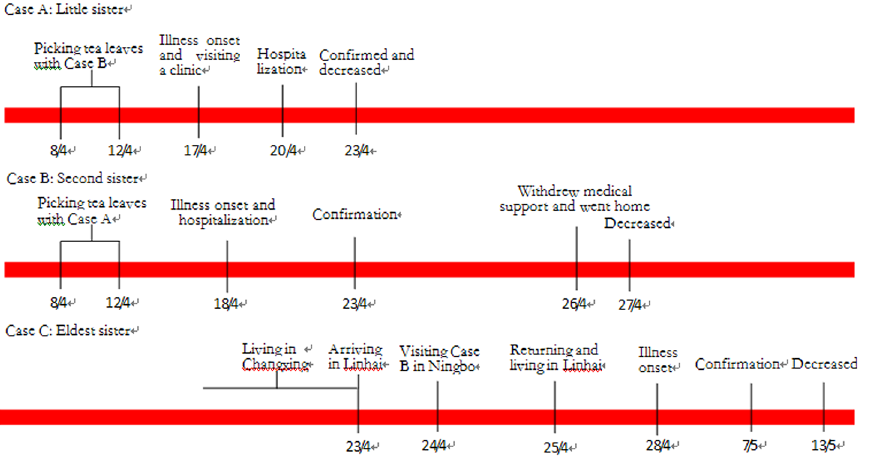
Fig 1. Timelines of key events for three SFTSV infections in southeastern